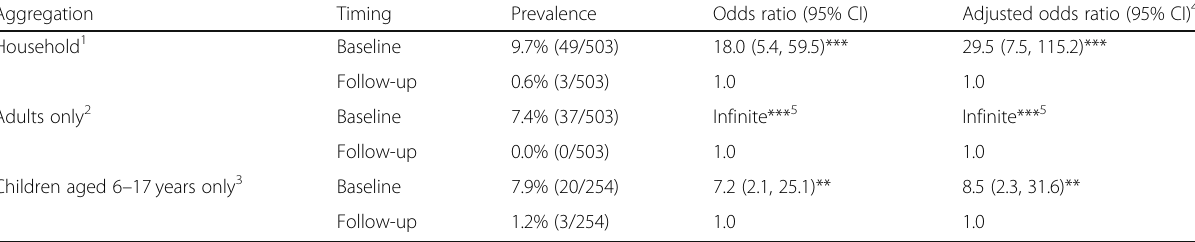
Table 4 Severe diarrhea by age group at baseline and follow-up Aggregation